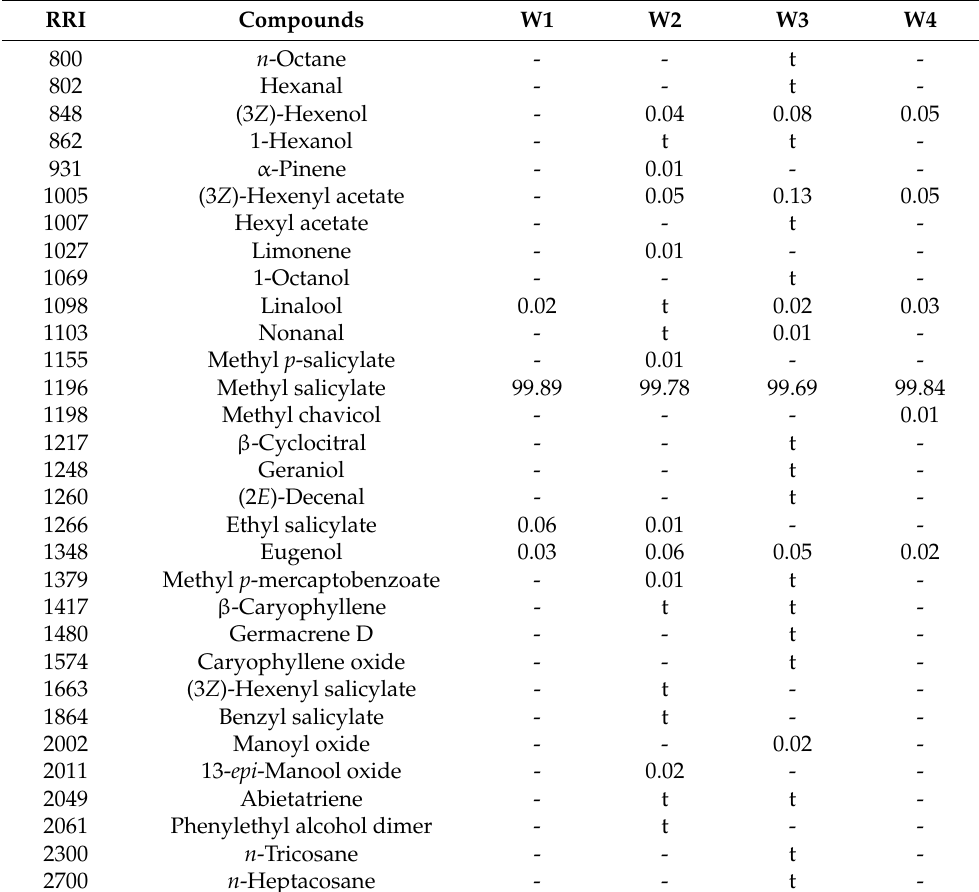
Table 2. Compositional analysis of wintergreen essential oil from different geographical locations a ; “-” indicates not detected and “t” indicates trace